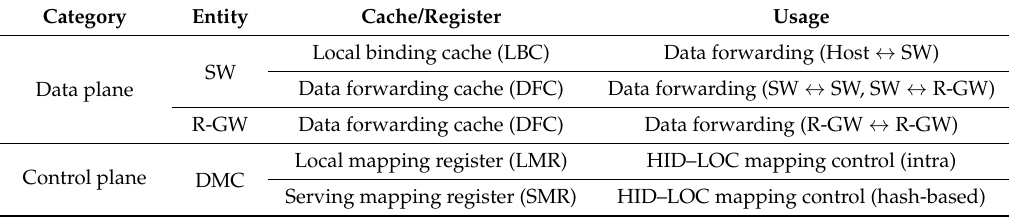
Table 2. Caches and registers. SW—switch; R ‐ GW—regional gateway; DMC—distributed mobility Caches and controller.